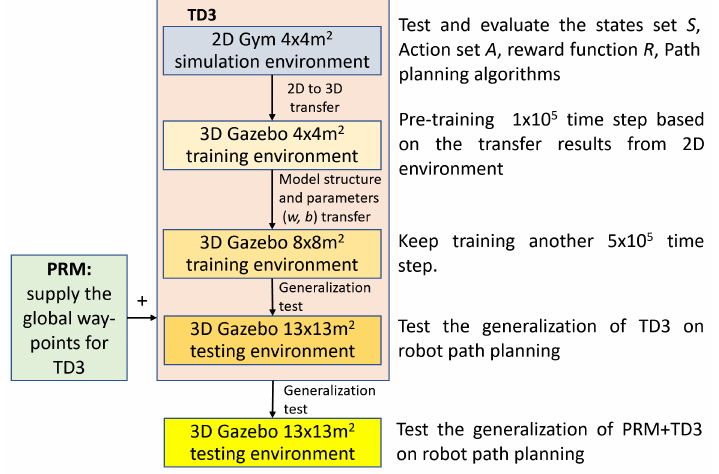
Figure 4. The incremental training process.